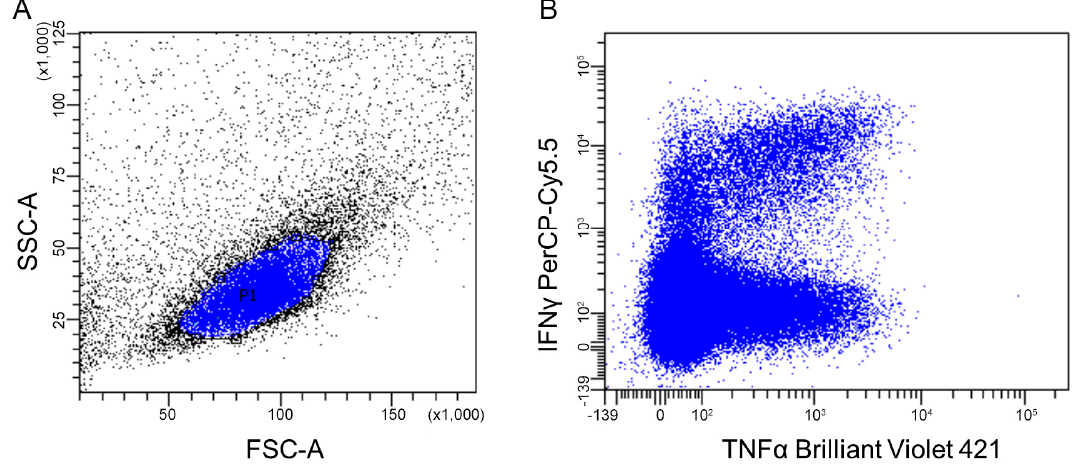
Figure 5. Application of flow cytometry to detect intracellular cytokines in porcine lymphocytes. ( A ) Activated cells with lymphoid scatter characteristics (highlighted in blue) from Melanoma–bearing Libechov Minipigs; ( B ) expression of IFN γ and TNF α in these cells.